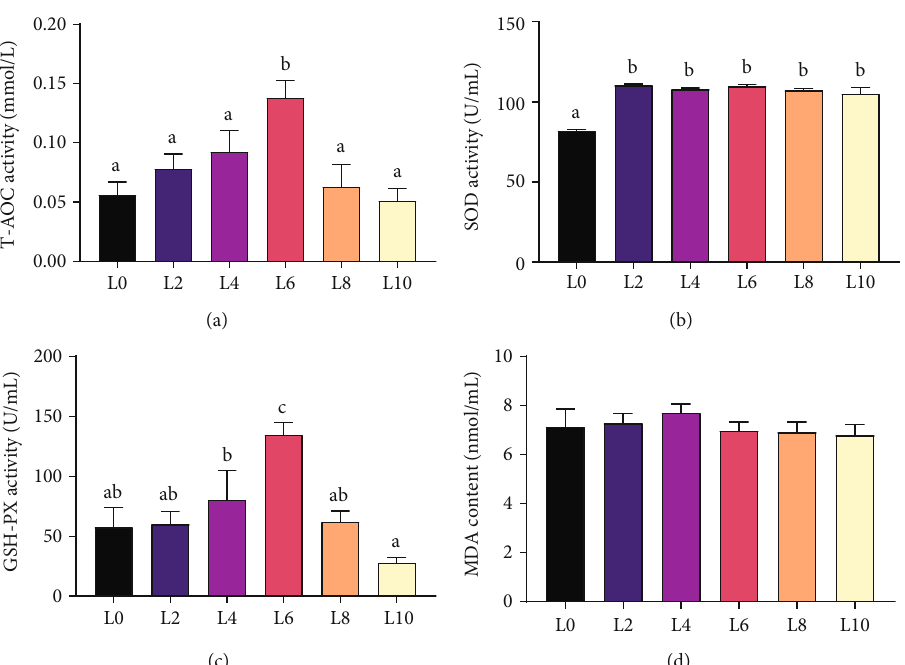
Figure 3: The activities of T-AOC (a), SOD (b), GSH-PX (c), and MDA (d) in the serum of C. quadricarinatus fed diets with di ff erent lipid levels. All data are expressed as the mean ± SE ( n = 6 ). Di ff erent letters indicate signi fi cant di ff erences among experimental groups ( P < 0 : 05 ).